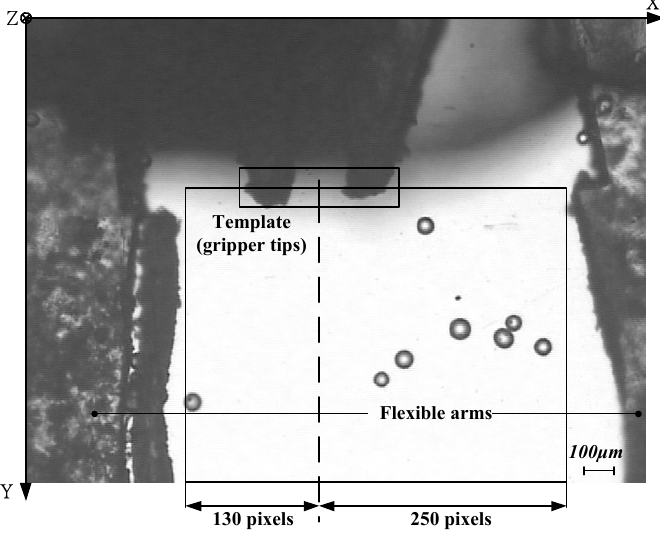
Figure 11. Horizontal planner area to constrain moving particles.